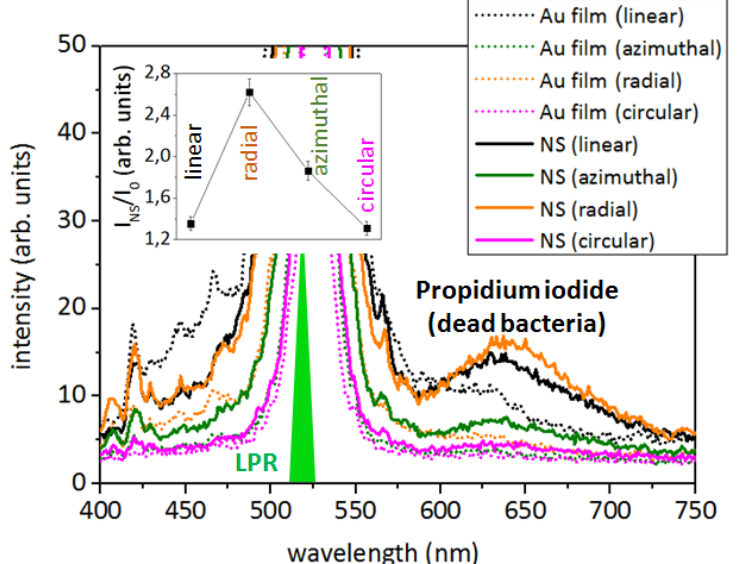
Figure 5. Photoluminescence spectra of the fluorescent dye propidium iodide, indicating the dead bacteria (broad peak at 620 nm) on the surface of the unstructured Au film and nanospikes (NS). The expected plasmon resonance (localized plasmon resonance, LPR) of the Au structures corresponds to 520 nm. Inset: normalized intensity of the propidium iodide peak at linear, radial, azimuthal and circular polarizations.